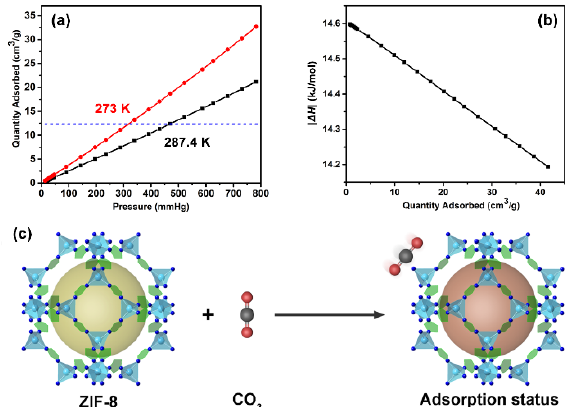
Figure 3. CO 2 adsorption ( a ) isotherm and ( b ) enthalpy curve tested by ASAP2020. The ( c ) CO 2 adsorption model of the ZIF-8.